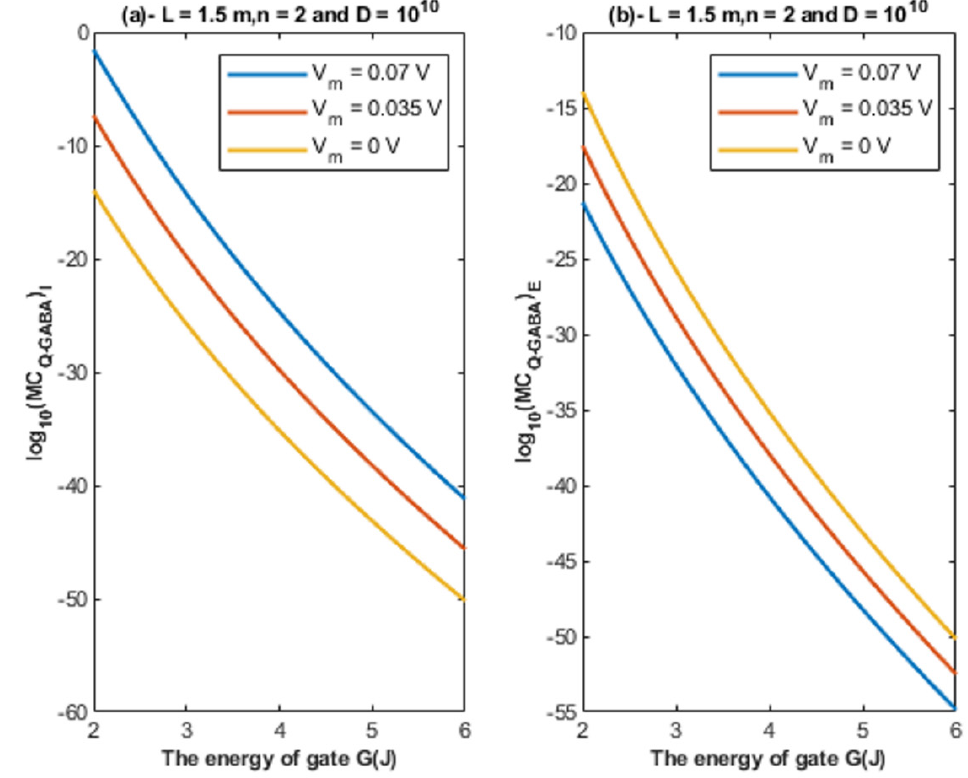
Figure 11. ( a,b ): The figure represents the relationship between the energy of the gate and the common logarithm of the quantum membrane conductance of the intracellular chloride ions ( MC ) log Q − GABA 10 I and the quantum membrane conductance of the extracellular chloride ions ( MC ) log Q − GABA 10 E , respectively. The relationships are investigated at different values of membrane potential and according to the setting values above each graph. Based on Equations (26) and (27), the relationship between the energy of the gate and the quantum membrane conductance is represented at different values of gate location. See Figure 12. Based on Equations (26) and (27), the relationship between the energy of the gate and the quantum membrane conductance is represented at different values of receptors density. See Figure